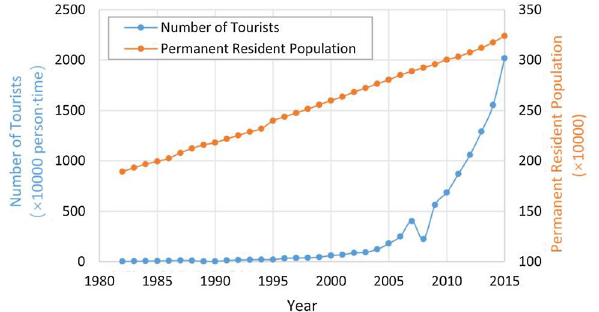
Fig. 6 Number of tourists and permanent residents in Tibet, 1982–2015 Source Tibet Autonomous Region Bureau of Statistics and Tibet General Team of Investigation under the NBS (2016)